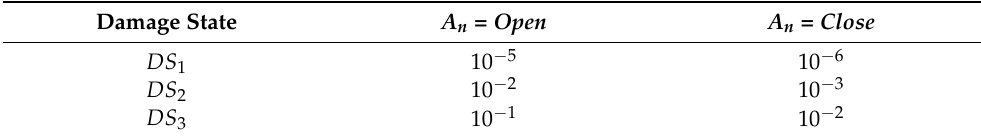
Table 2. Probabilities of failure for different damage states and actions.